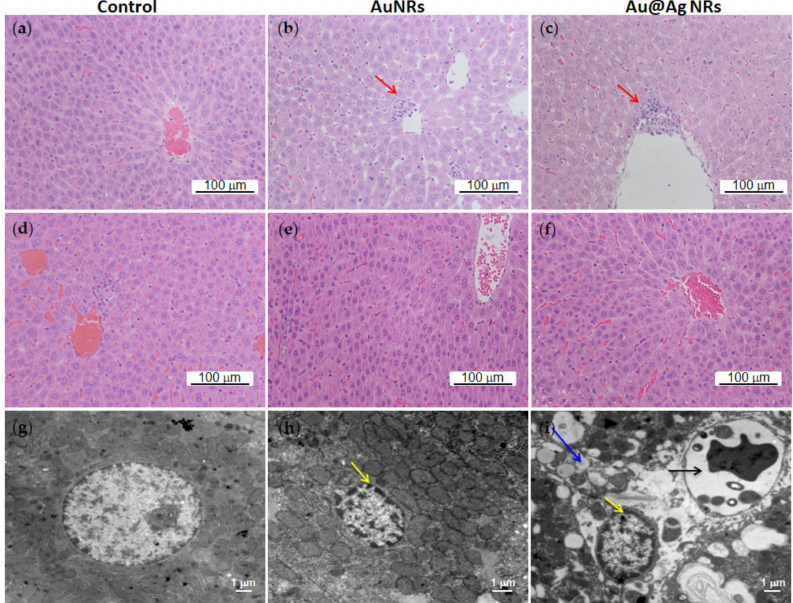
Figure 4. The changes of liver tissues. The liver tissues collected at 2 or 8 w after injection were sectioned. ( a – c ) Repre- sentative HE images at 2 w. ( d – f ) Representative HE images at 8 w. ( g – i ) Representative TEM images at 2 w. Red arrow, inflammatory foci. Yellow arrow, pyknotic nuclei. Blue arrow, cellular vacuolization. Black arrow, nuclear